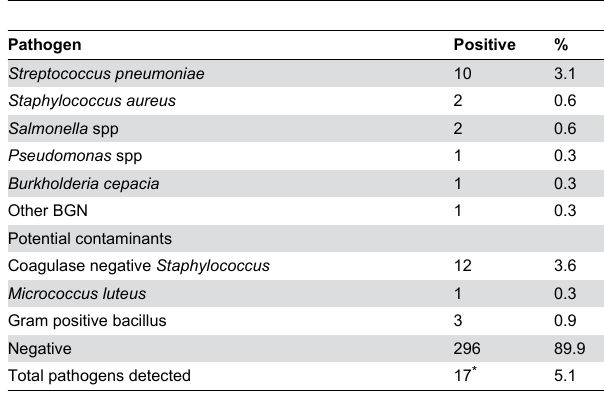
Table 2. Distribution of isolates by bacterial culture among children of Mozambique and